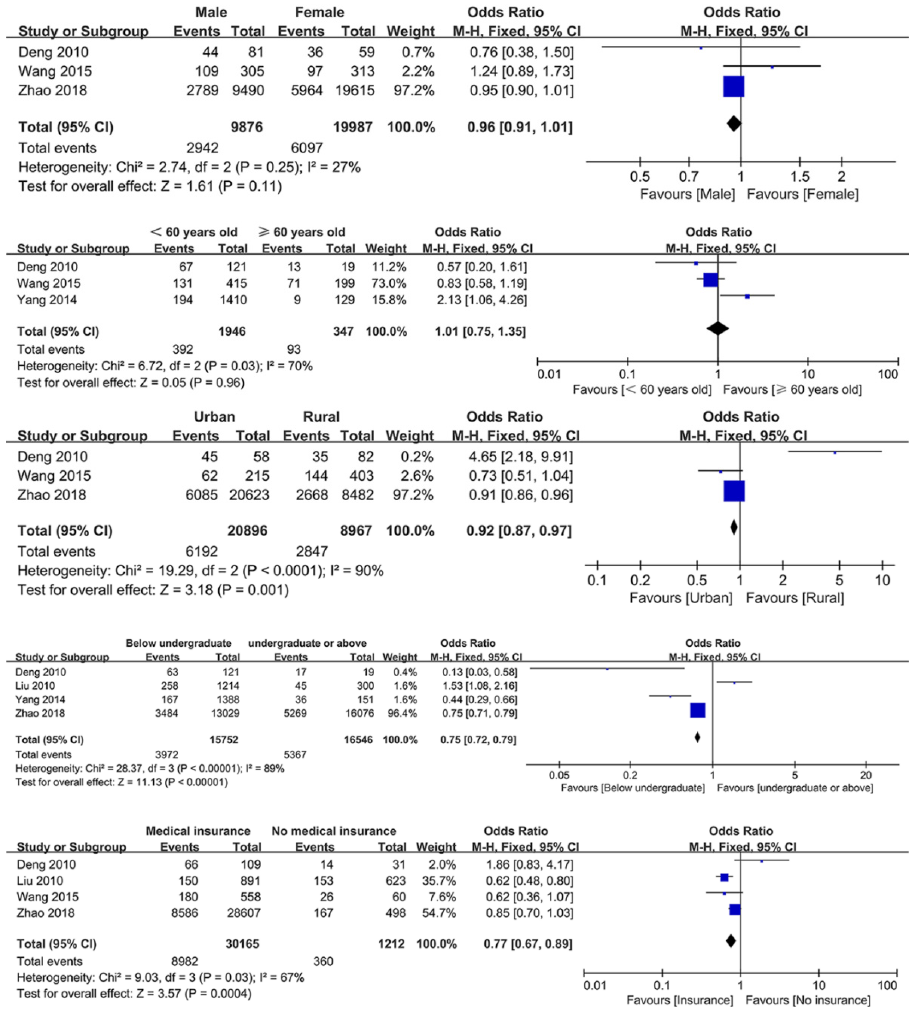
Figure 3. Forest plots of patient-related